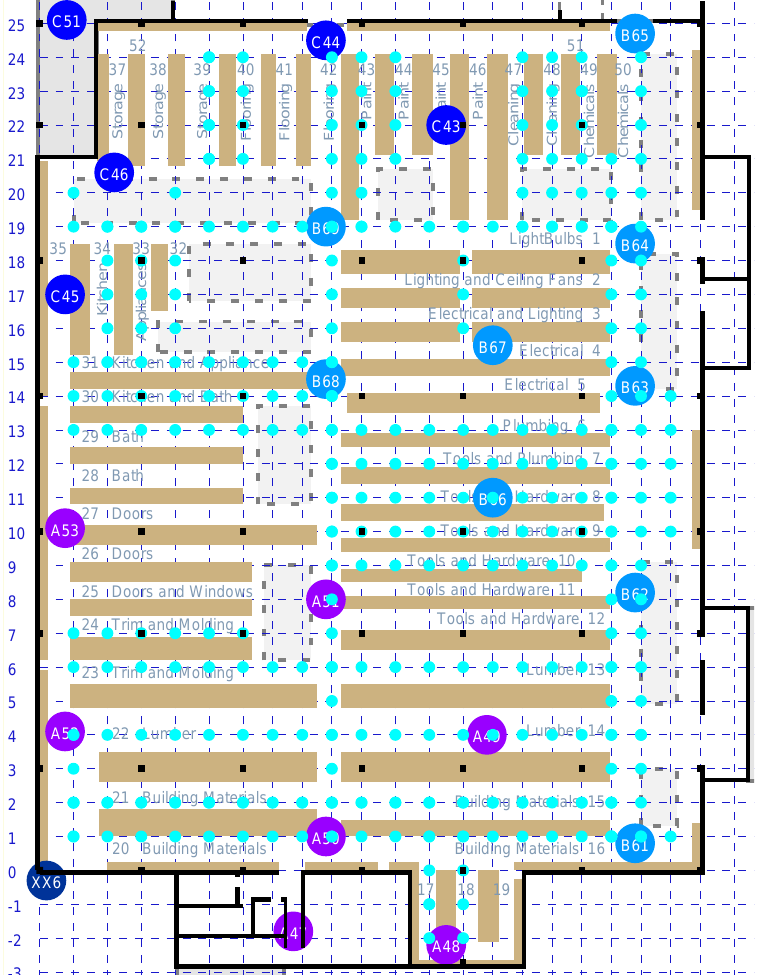
Figure 1. Floor plan of a box store with 20 APs marked with large colored circles. The main floor area is about 82 m by 107 m. Beige rectangles denote shelves filled with merchandise. Cyan-colored dots indicate 278 points with known coordinates that are accessible (e.g., not under shelves). These are at the intersections of lines in the concrete floor, indicated using dashed